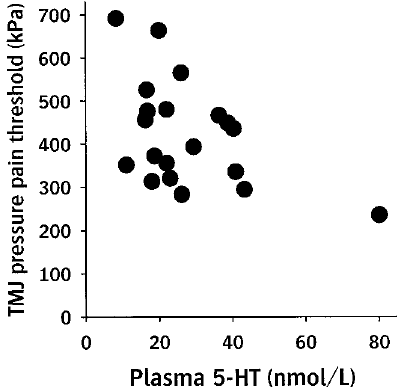
FIG. 3. The relation between the plasma level of 5-HT and the sum of pressure pain thresholds over the lateral aspects of the right and left temporomandibular joints in 20 healthy individuals ( r s = –0.47, n = 20, p =